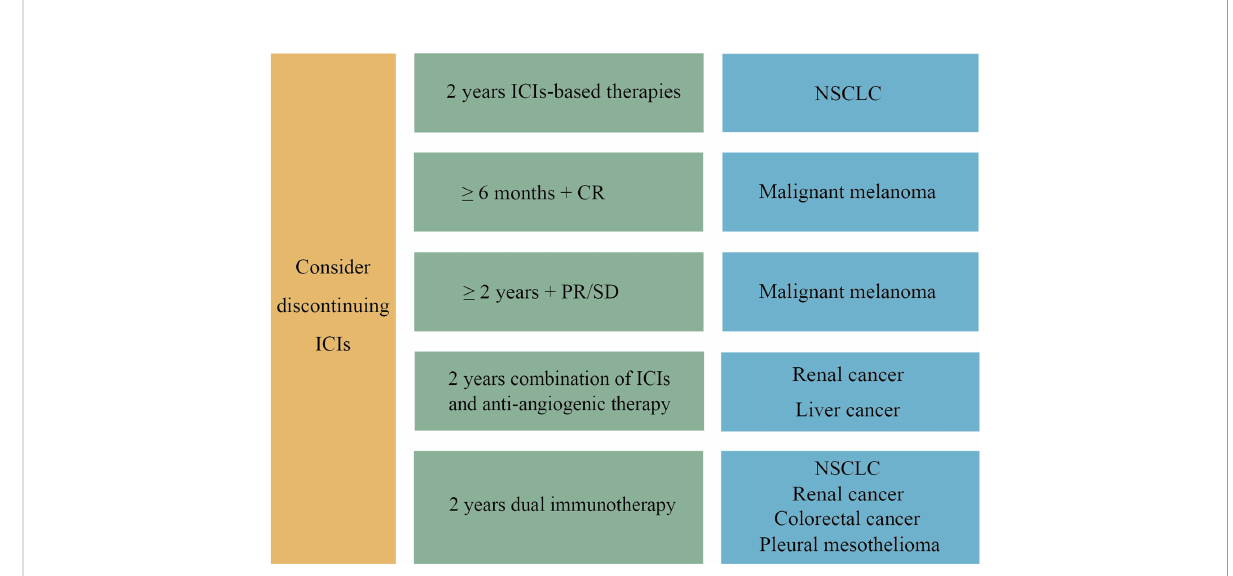
FIGURE 2 The optimal duration of ICIs in different tumor types. For NSCLC, we recommend that discontinuation be considered when 2 years of ICIs- based therapy are completed. For advanced malignant melanoma, early discontinuation of ICIs can be considered in CR patients ready to receive additional treatment for 6 months after achieving CR. If the ef fi cacy is assessed as PR or SD after two years of ICIs treatment, cessation may be taken into account. A two-year combination of ICIs and anti-angiogenic therapy is the main fi rst-line treatment option for advanced liver cancer and renal cancer. In addition, dual immunotherapy has been approved as a fi rst-line treatment for various cancers, including NSCLC, advanced renal cancer, colorectal cancer and pleural mesothelioma, with the same recommendation of two years duration. After two years of ICIs treatment, drug withdrawal can be